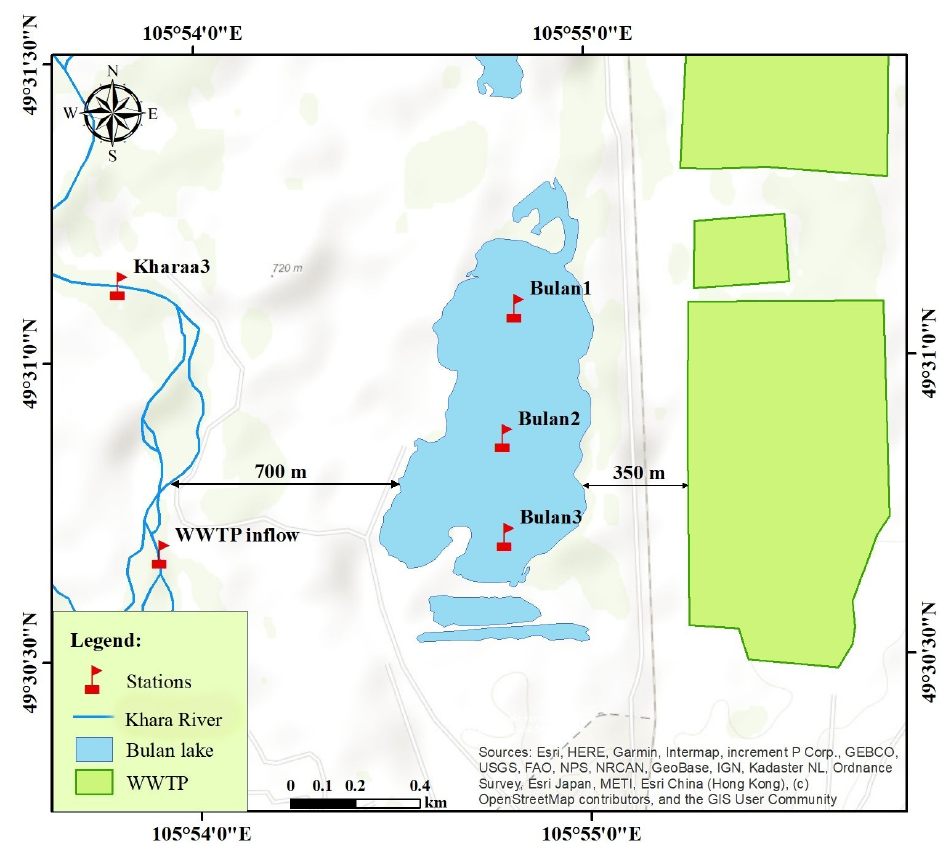
Figure 1. Research area: stations at Lake Bulan. Map cited from Sources: Esri. HERE. Garmin. Intermap. Increment P Corp., GEBCO, USGS, FAO. NPS, NRCAN. GeoBase. IGN. Kadaster NL. Ordnance Survey. Esri Japan, METI, Esri China (Hong Kong), Open Street map contributors, and the GIS User Community and is modified.